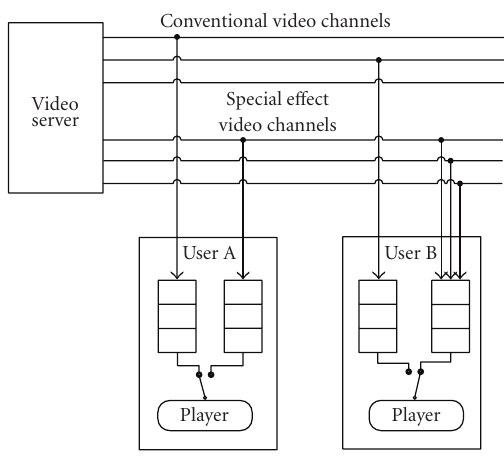
Figure 3: The overview of IP multicast for online user service.